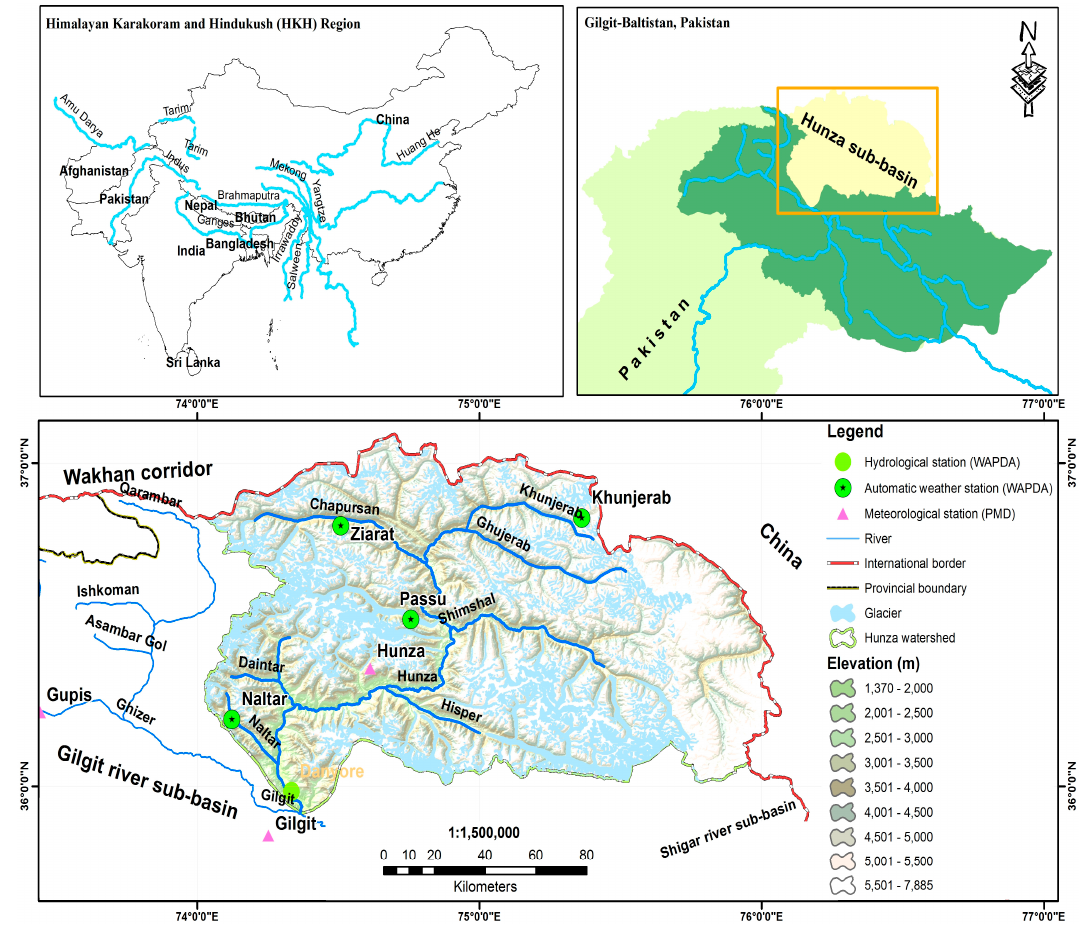
Figure 1. Map of the study area.